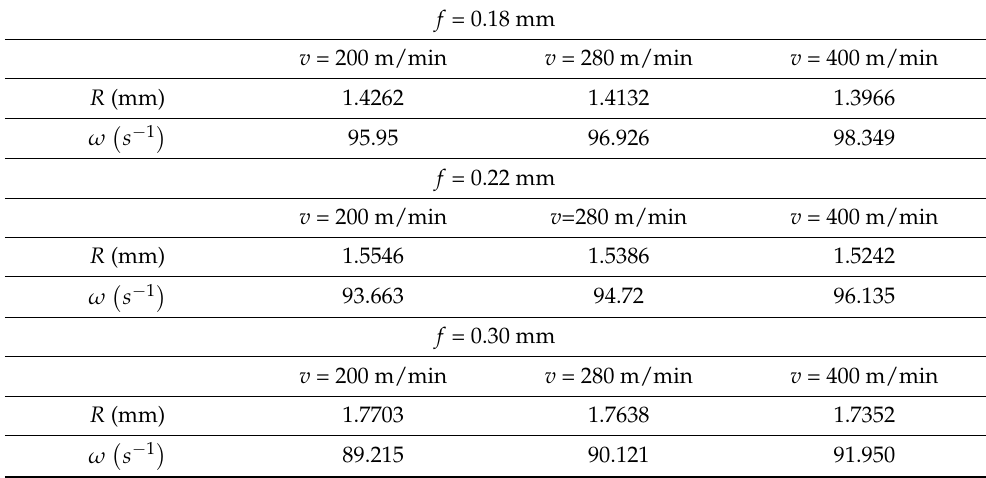
Table 2. Amplitude R and frequency ω of vibration for various values of feed rate f and velocity v .